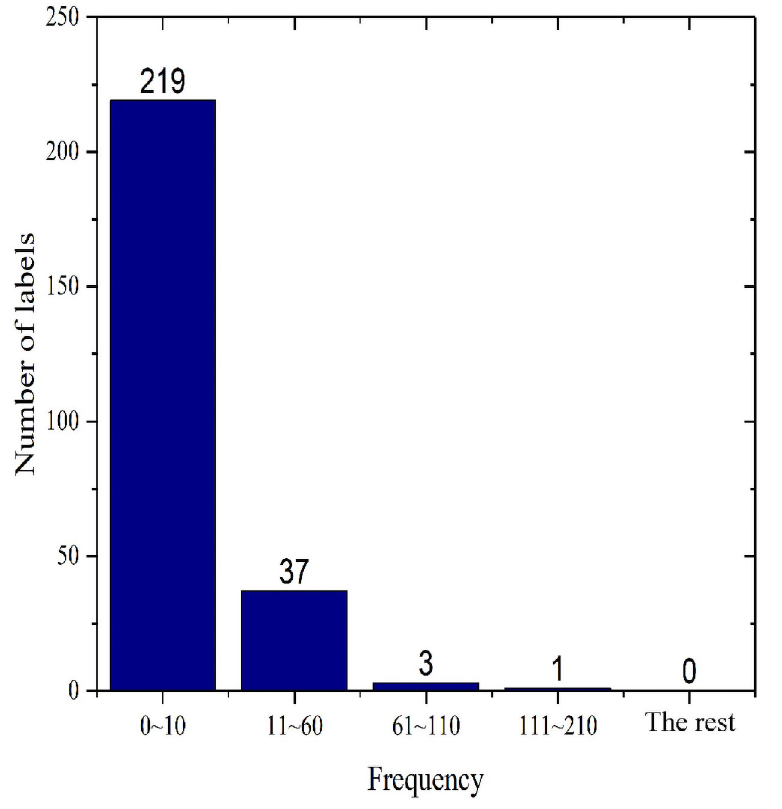
Fig 5. Corel5k test set label